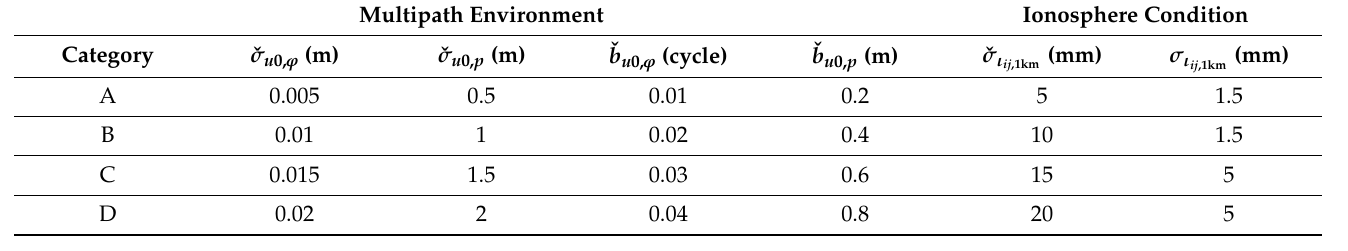
Table 7. Overbounding parameters used for different categories of the multipath environments and ionosphere conditions.